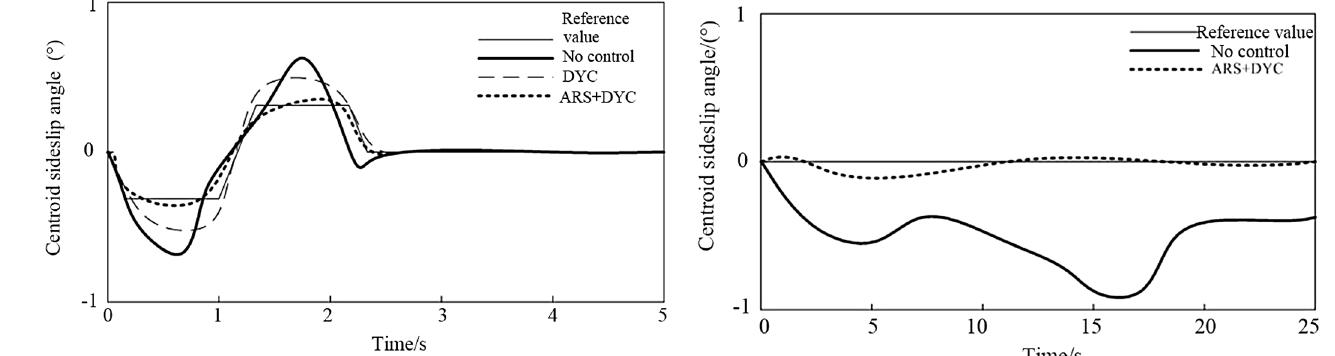
Fig. 3. Centroid sideslip angle response.